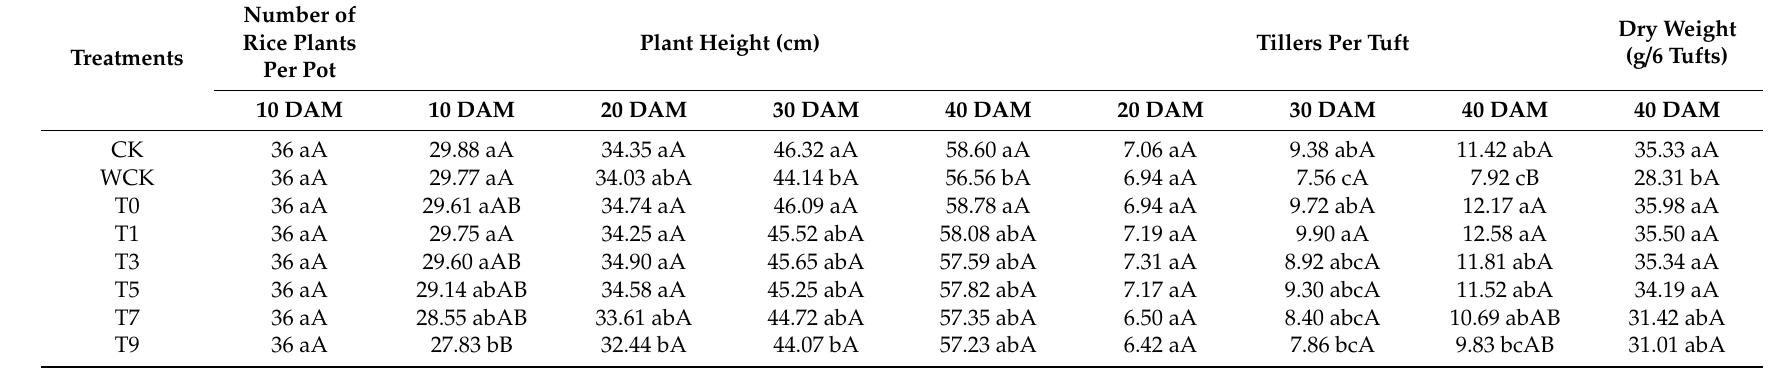
Table 3. E ff ect of oilseed rape straw mulch in simulated transplanted